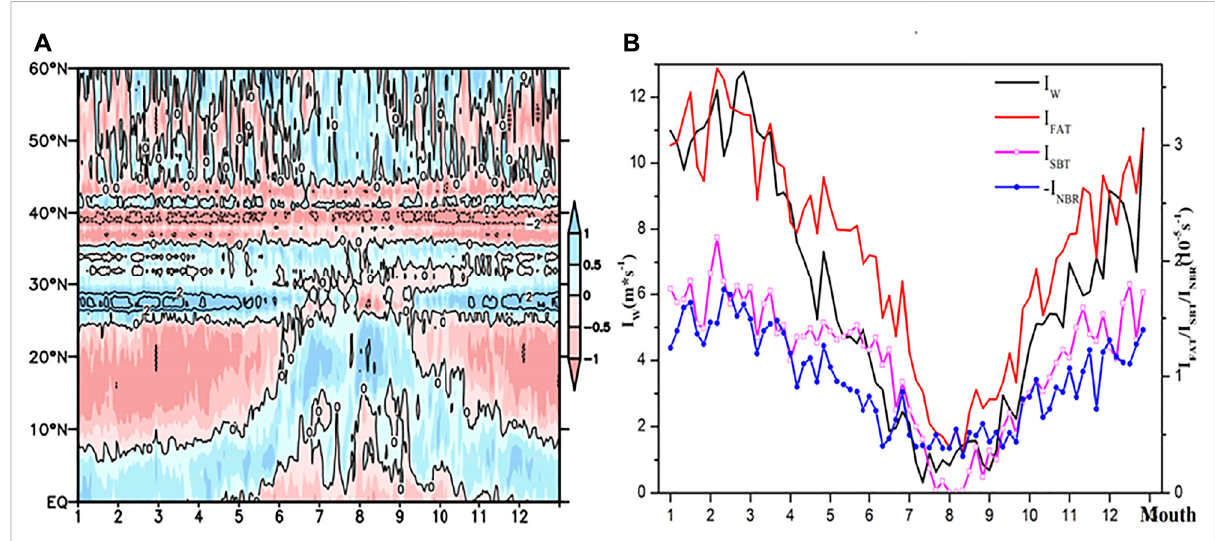
FIGURE 4 The pentadevolutionof climatic meanof (A) vorticity(unit: 10 − 5 s-1) in70 – 100 ° Eat600 hPa and (B) I W (unit:m s-1), I FAT (unit: 10 − 5 s-1), I SBT (unit: 10 − 5 s-1) and I NBR (unit: 10 − 5